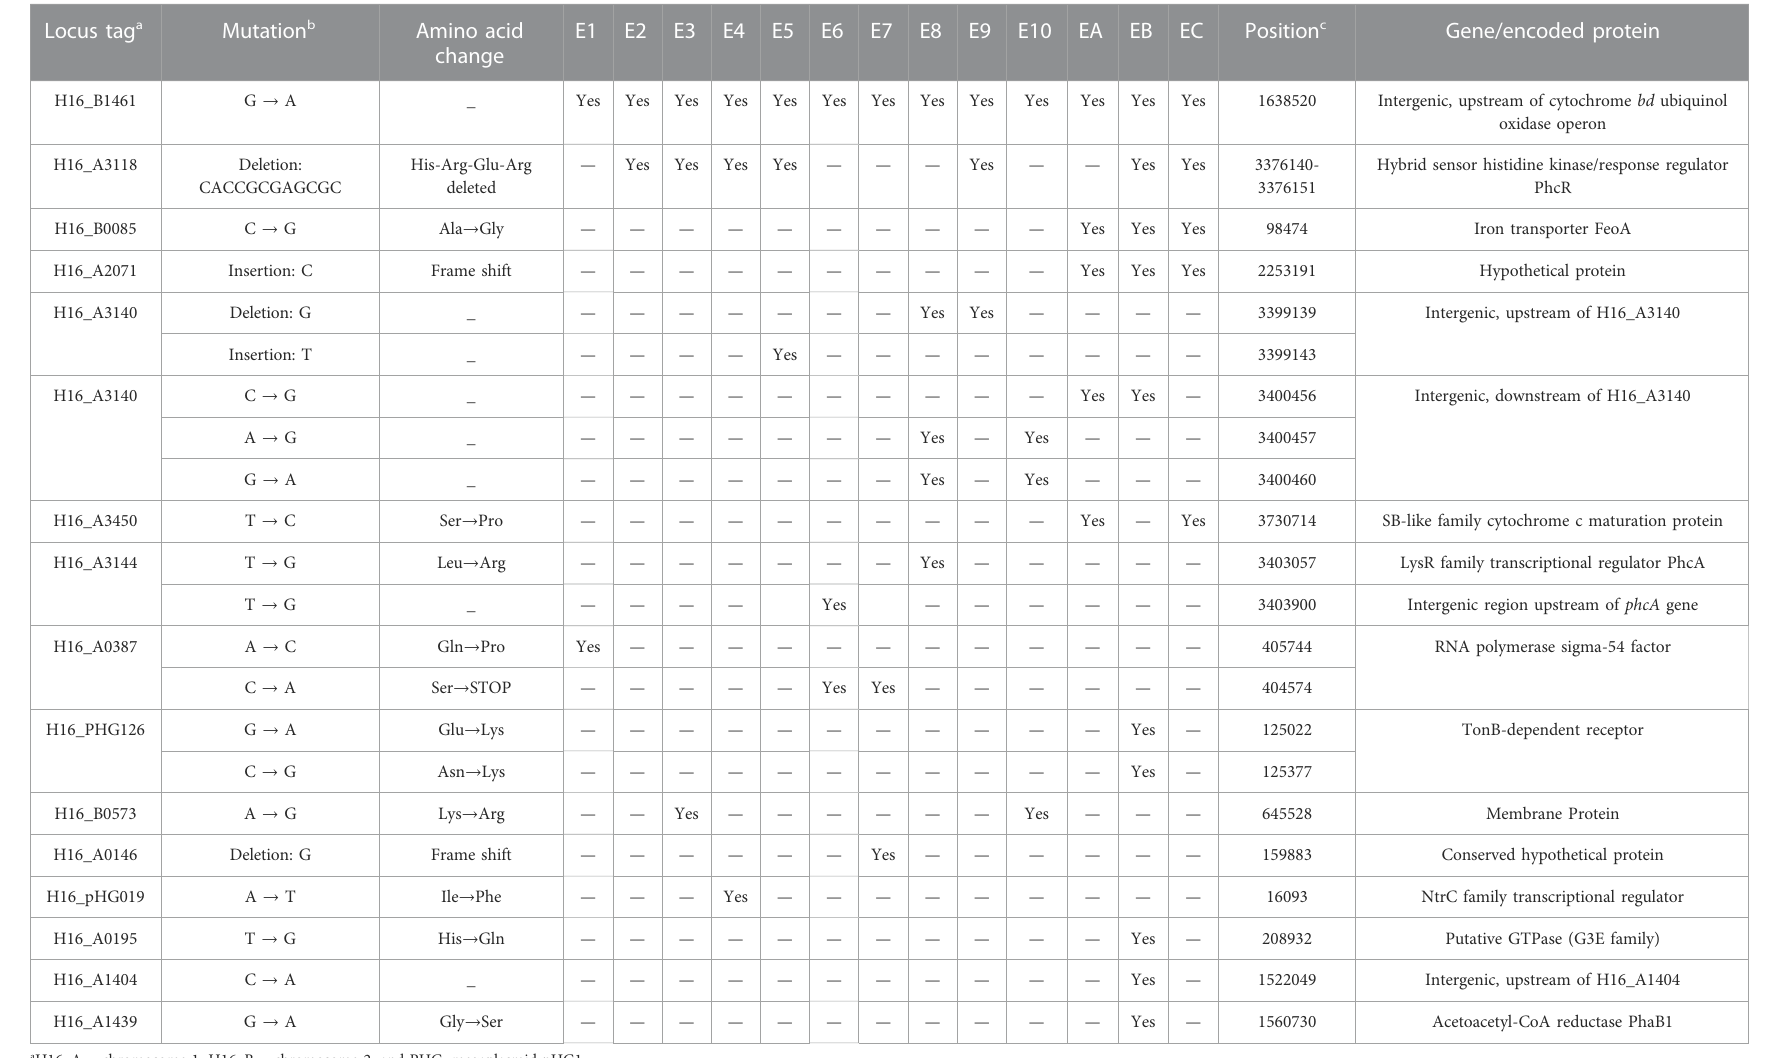
TABLE 3 Comparison of mutations across C. necator E1 — 10 and C. necator A, B & C. Locus tag